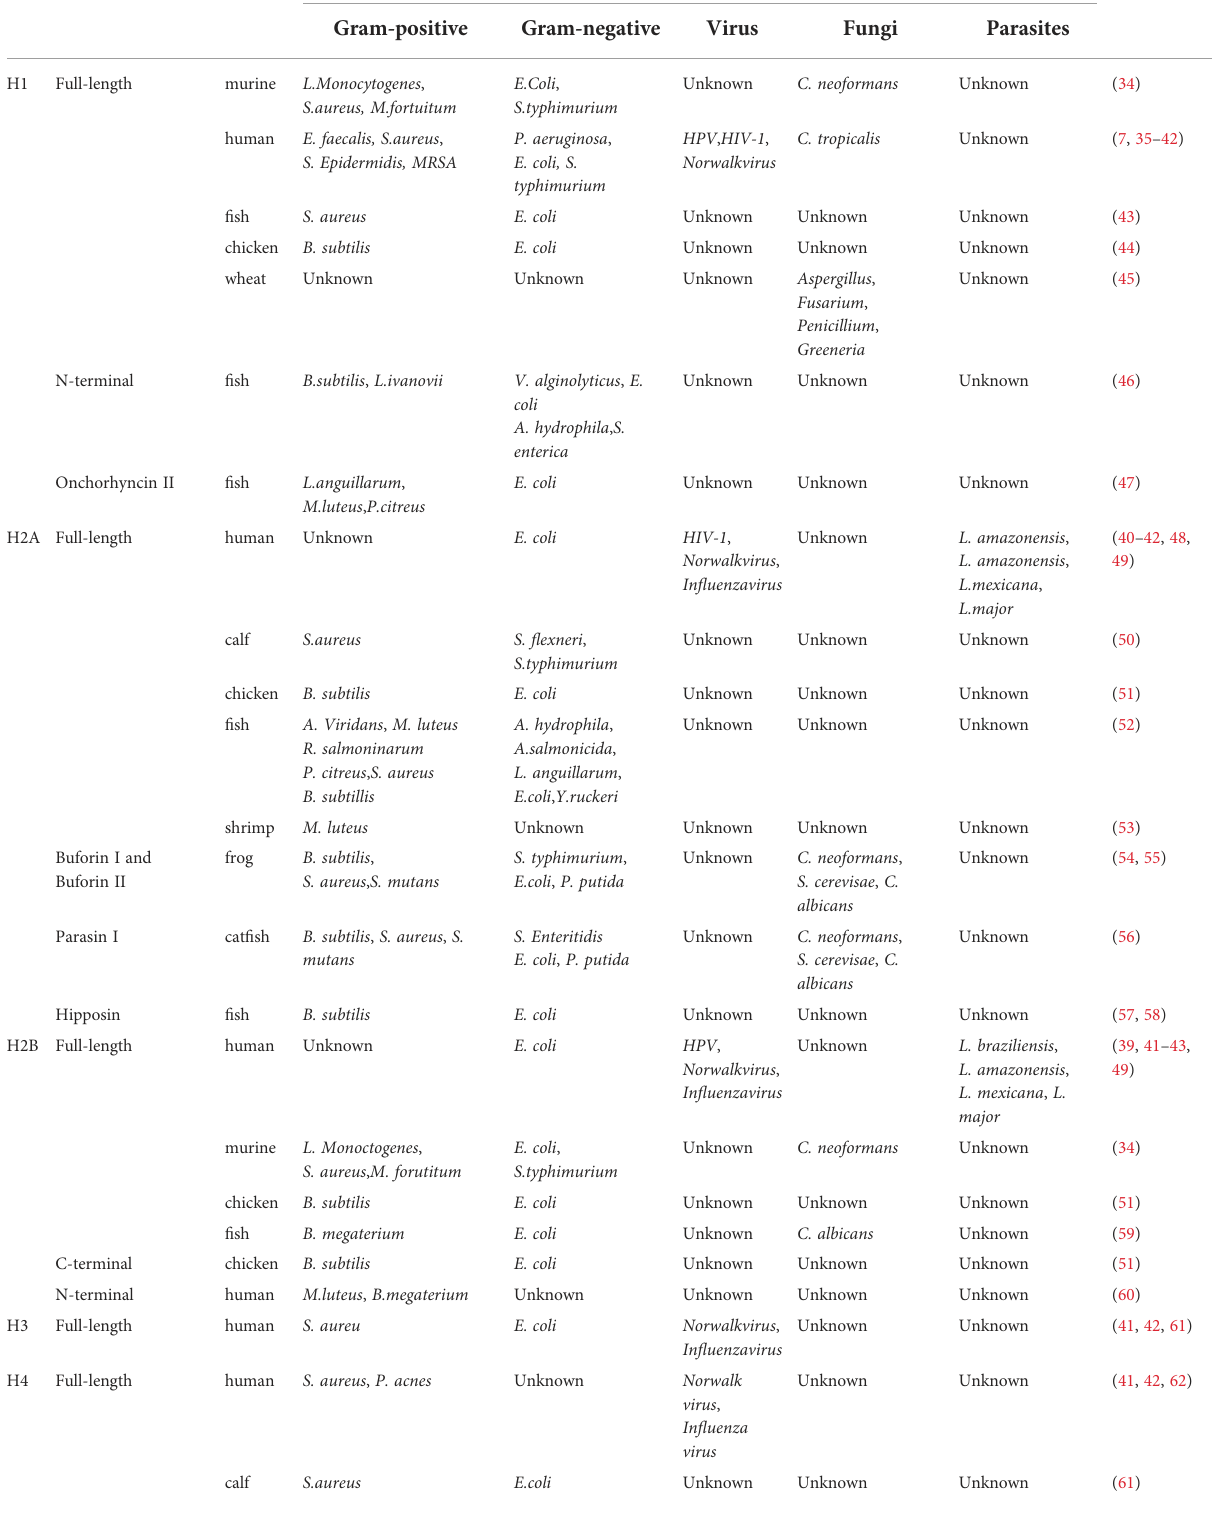
TABLE 1 Antimicrobial activity of his tones and his tone fragments.